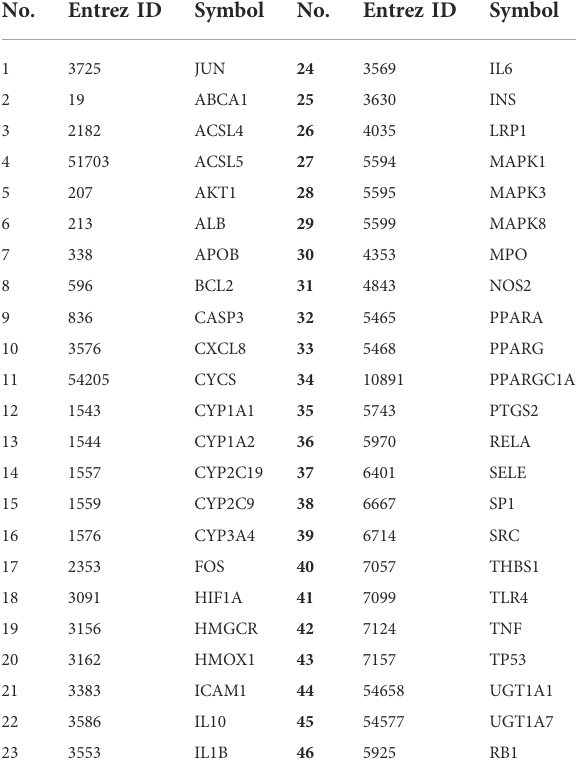
TABLE 3 46 potential target genes on YFBP against